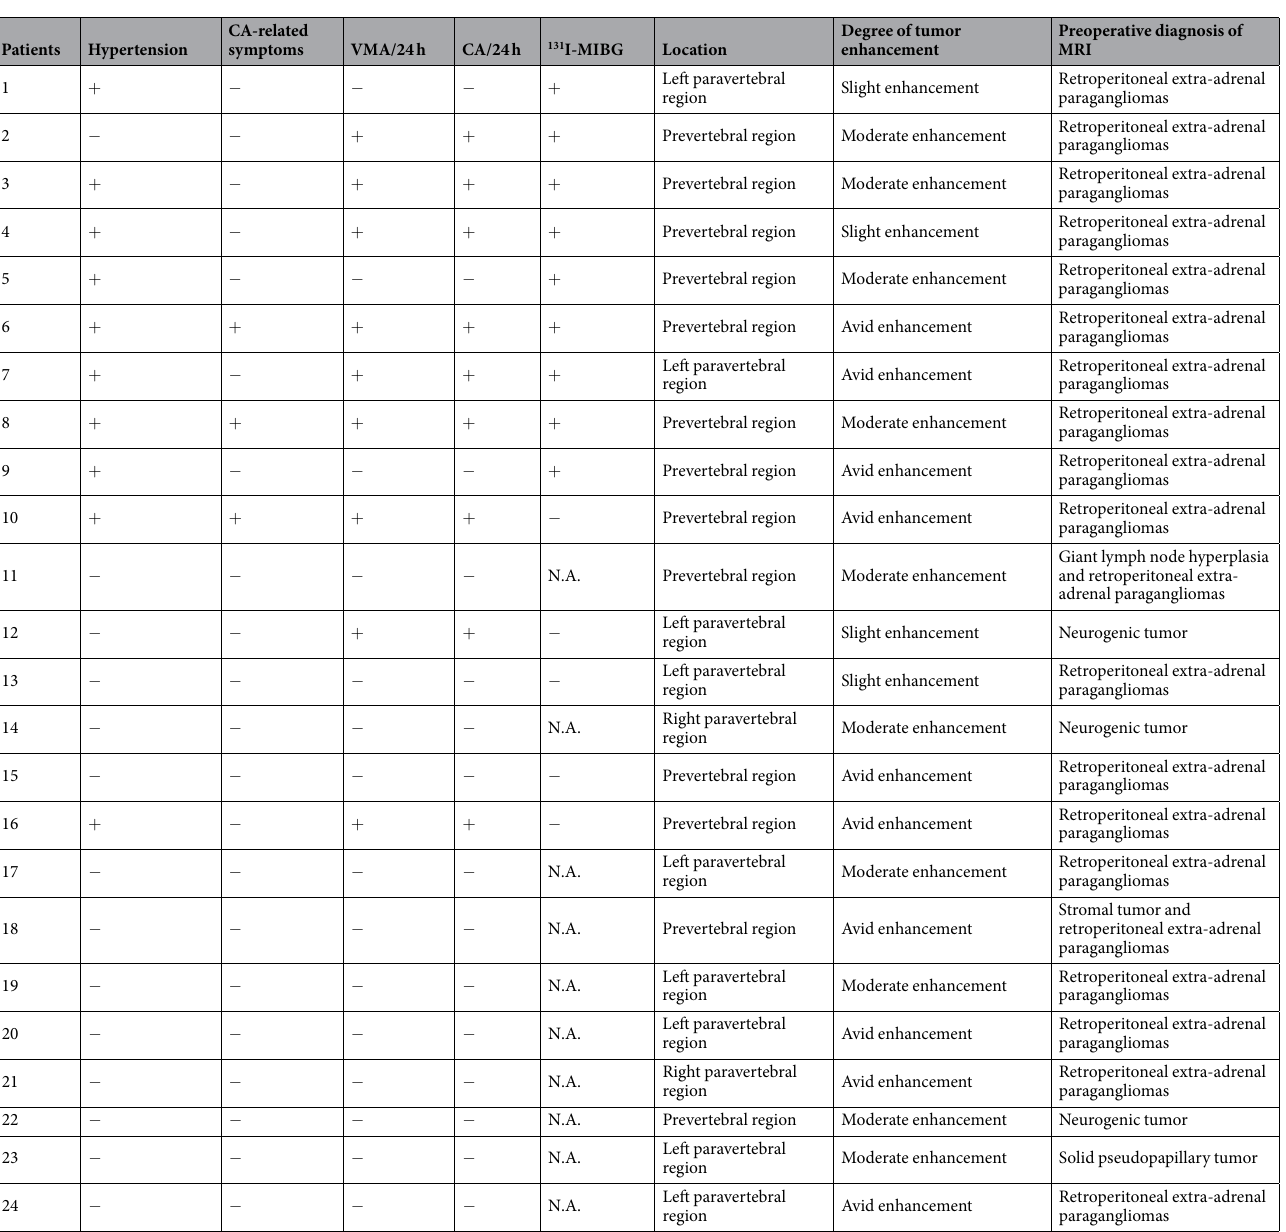
Table 5. Major clinical data, MR imaging features and diagnostic findings. Note: − , negative; + , positive; N.A., not